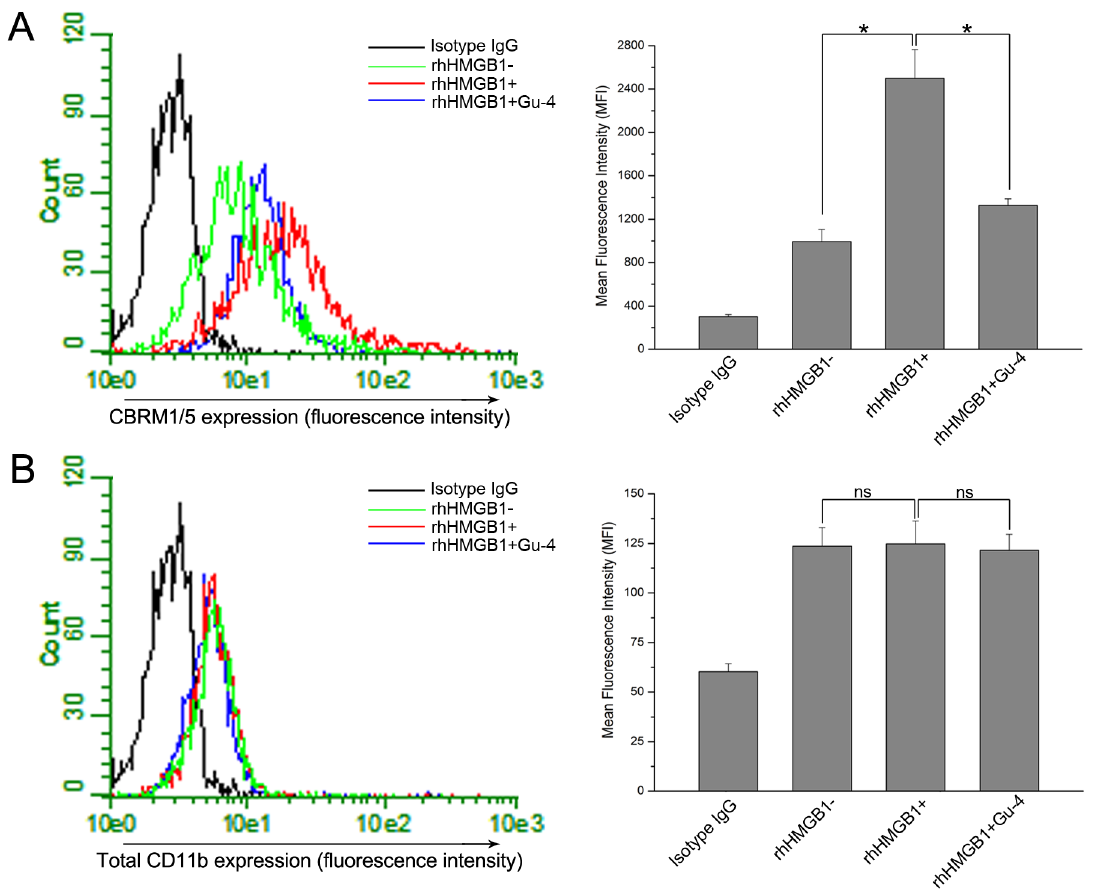
Figure 5. FACS analysis of Gu-4 on the activation and expression of b 2 integrin CD11b on rhHMGB1-stimulated THP-1 cells. In the absence (or presence) of Gu-4 (80 m M), THP-1 cells were stimulated with (or without) rhHMGB1 (200 ng/ml) for 20 min, then the samples were subjected to co-incubation with saturating amount of PE conjugated CBRM1/5 (or PE labeled sc-1186) for 10 min. Quantitative cell surface expression of CD11b I-domain and CD11b were analyzed by FACS. A: Effects of Gu-4 on the exposure of CD11b I-domain induced by rhHMGB1. B: Effects of Gu-4 on the expression of CD11b induced by rhHMGB1. Data shown are representative results of triplicate experiments. The relative amount was determined by measurement of fluorescence intensity. *, p , 0.05. ns, non significant.